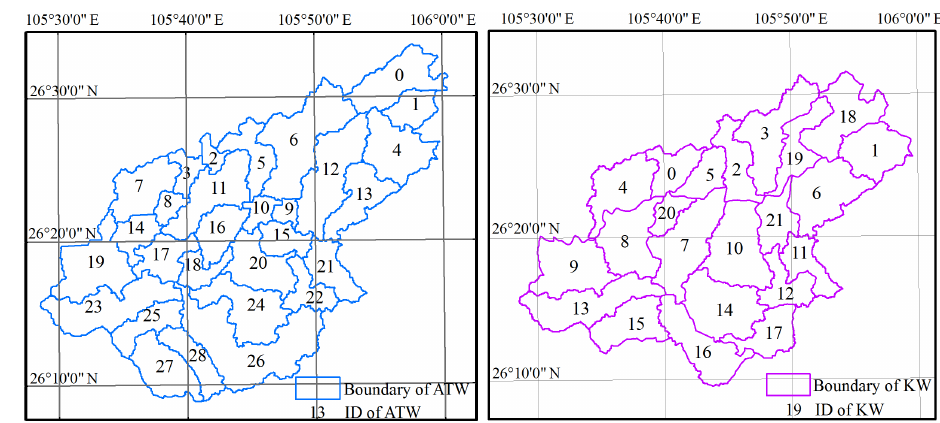
Figure 5. A quantitative contrast between karst watersheds (KW) and auto-delineating topographic watersheds (ATW).